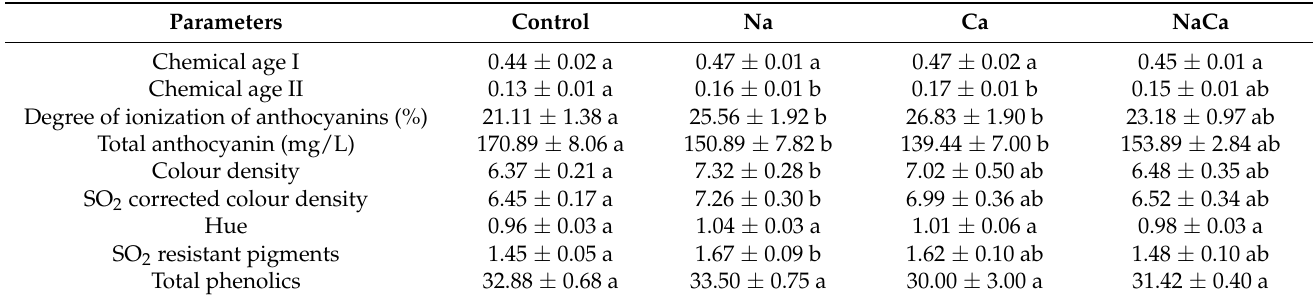
Table 3. Colour parameters of resultant wines measured by modified Somer’s